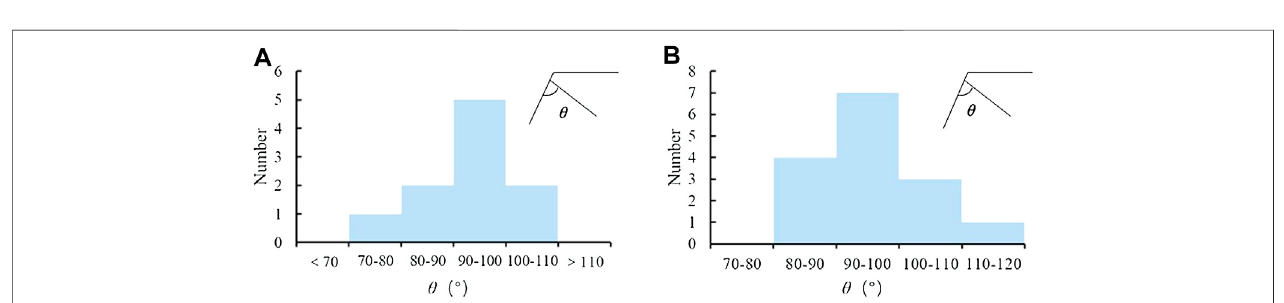
FIGURE 6 | Cases of fl exural toppling deformation: (A) cases from typical example; (B) cases from bank slope on the Miaowei Hydropower Station.